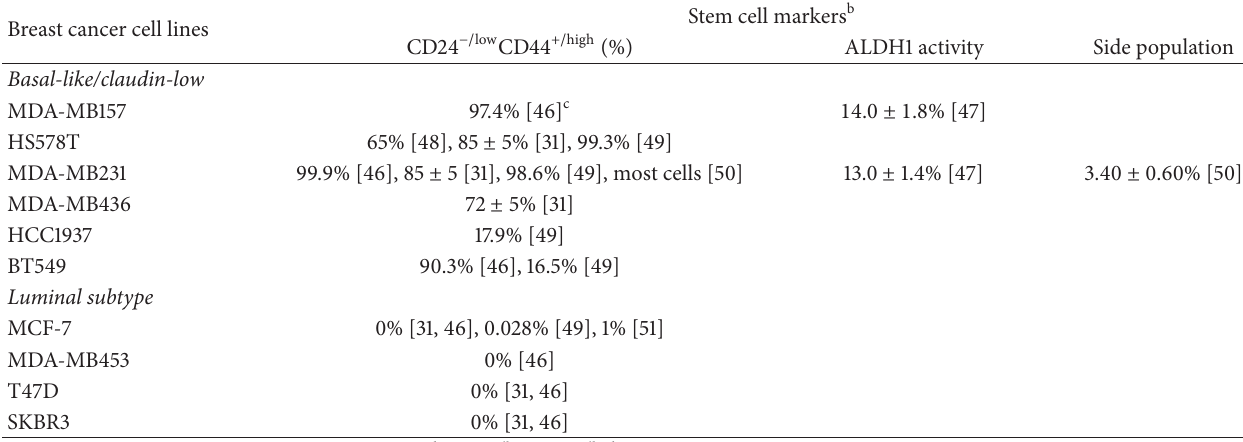
Table 4: Cancer stem cell population in different breast cancer cell lines a